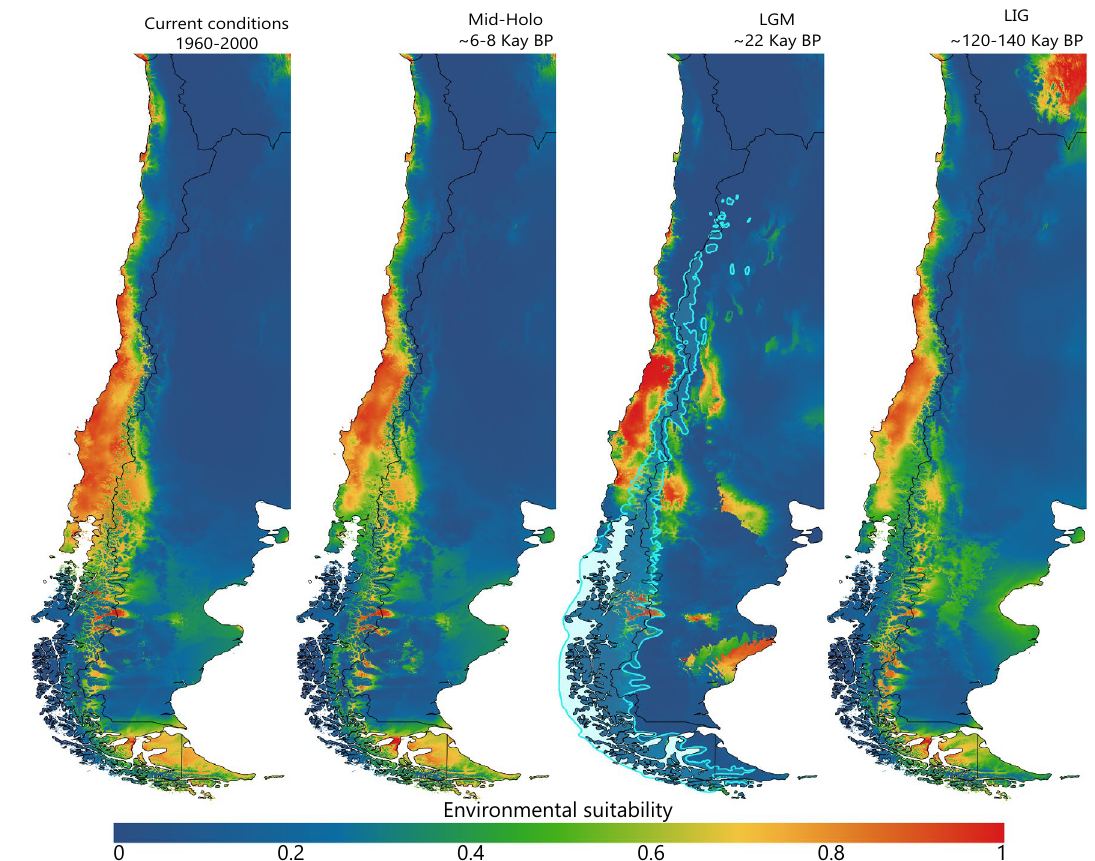
Figure 4. Potential geographic distribution of the climatically suitable areas for Abrothrix olivacea onto the climatic scenarios explored from present to past (Current conditions: 1960–1990; Mid-Holocene: ∼ 6–8 Kay BP; Last Glacial Maximum: ∼ 22 Kay BP; Last Interglacial: ∼ 120–140 Kay BP). Each panel depicts the spatial projection of the climatic niche model constructed for this species in the climatic scenarios explored. The light blue shading represents the extent of the Patagonian Ice Sheet during the LGM according to McCulloch et al. 112 . Climatic-Environmental suitability values are depicted as continuous representation and areas with warmer colors indicate regions whit higher climatic